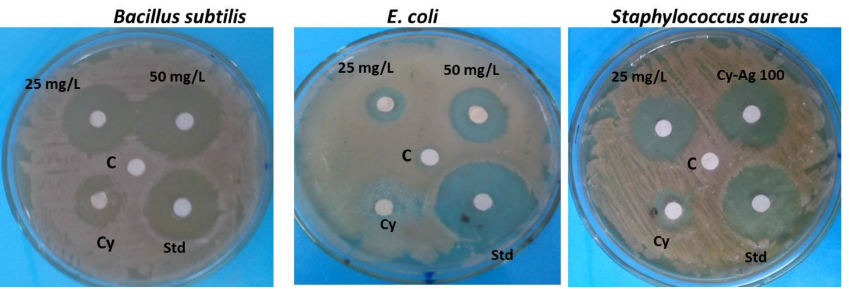
Figure 8. Antibacterial activity of C. acutum latex and different Cy-AgNP concentrations (25 and 50 mg/L) against different bacterial strains; Cy: 3% C. acutum latex; Std: gentamicin (10 µ g) and C: negative control.